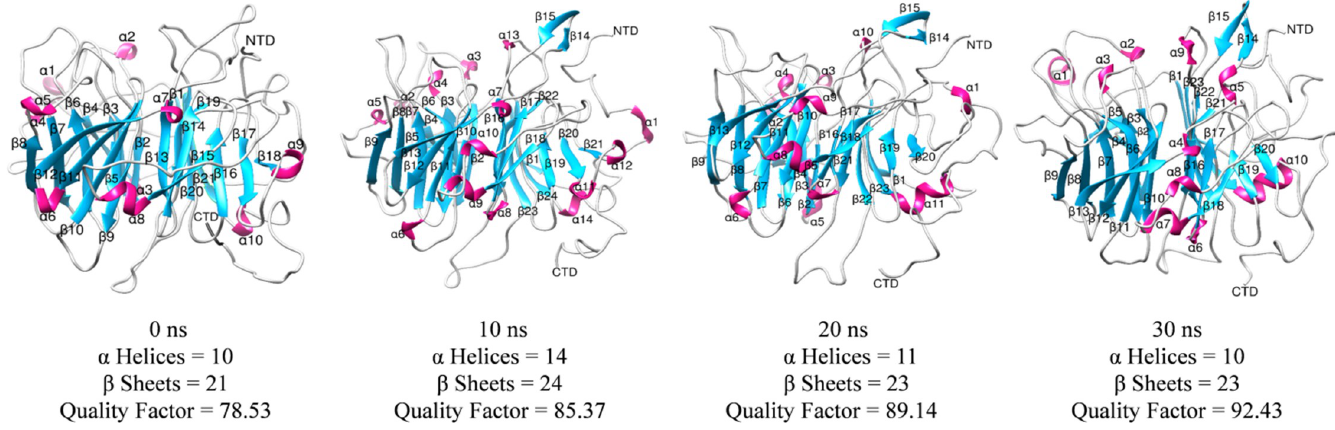
Fig 4. Structural details of the simulated structure of MRJP1 at 0 ns, 10 ns, 20 ns, and 30 ns.